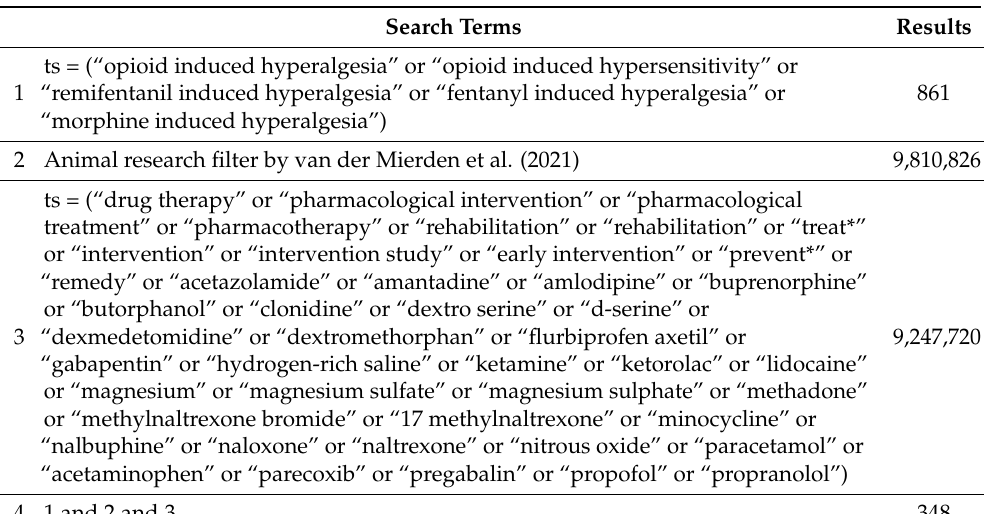
Table A8. Final Web of Science search (via Clarivate). The number of records retrieved for the disease of interest (1), animal research (2), interventions (3), and their combinations